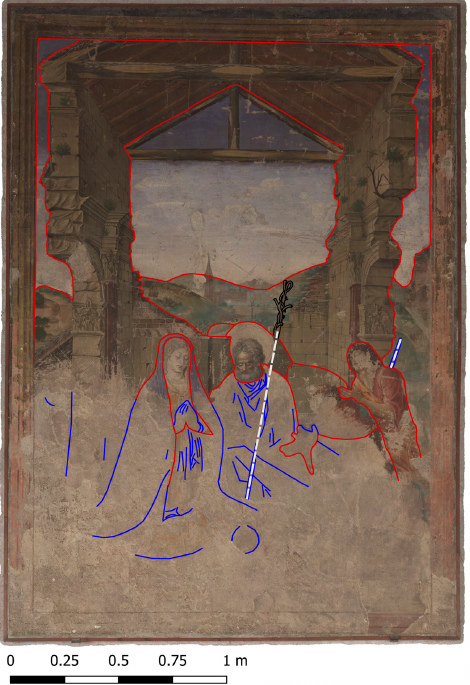
Figure 12. Visible induced visible reflectography image with tracings based on the hybrid images. Red: plaster borders, giornata ; Blue: Underdrawings and pentimenti ; White: reconstructed line of the shepherd’s crooks; black: highlighted top of Joseph’s rod.